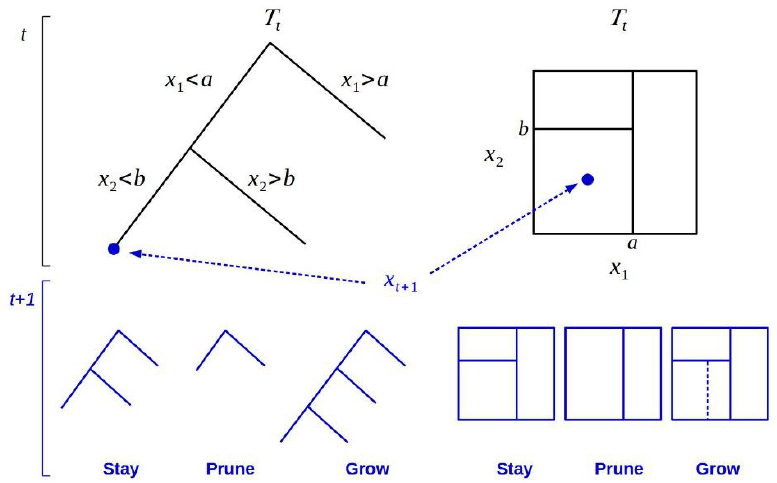
Figure 1. Prior possibilities for tree change T t (black) to T t + 1 (blue) upon arrival of a new data point x t + 1 at t + 1. ( Left ) tree structure and ( Right ) partition of the sample space. This figure has been adapted from [25].